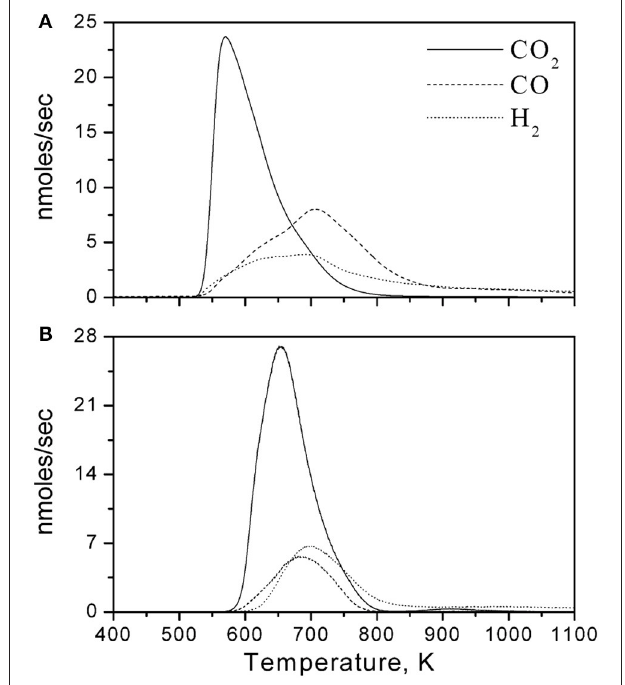
FIGURE 2 | Temperature-programmed oxidation (TPO) of surface carbonaceous species (C c , CH x O y ), deposited during equilibrium dissociative adsorption of CH 4 (A) on Ni(Au 0.2%at)/YSZ at 773K with initial amount of CH 4 17.7 µ mol, and (B) on Ni(Au 1.0%at)/YSZ at 723K with initial amount of CH 4 24 µ mol. After the equilibration of the surface with CH 4 and the formation the carbonaceous adsorbed species (CH x ) the reactor was cooled down to room temperature and was purged with Ar. Thereafter, a certain O 2 quantity was adsorbed on the surface corresponding to twice the amount of deposited surface carbon. Ramp rate: 20 K/min. Ar molar flow rate = 26 µ mol/s. Reprinted with permission from Triantafyllopoulos and Neophytides